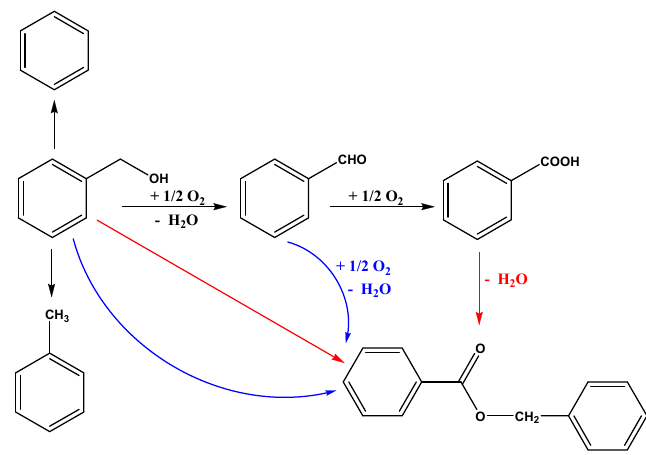
Scheme 1. The reaction route of aerobic oxidation of benzyl